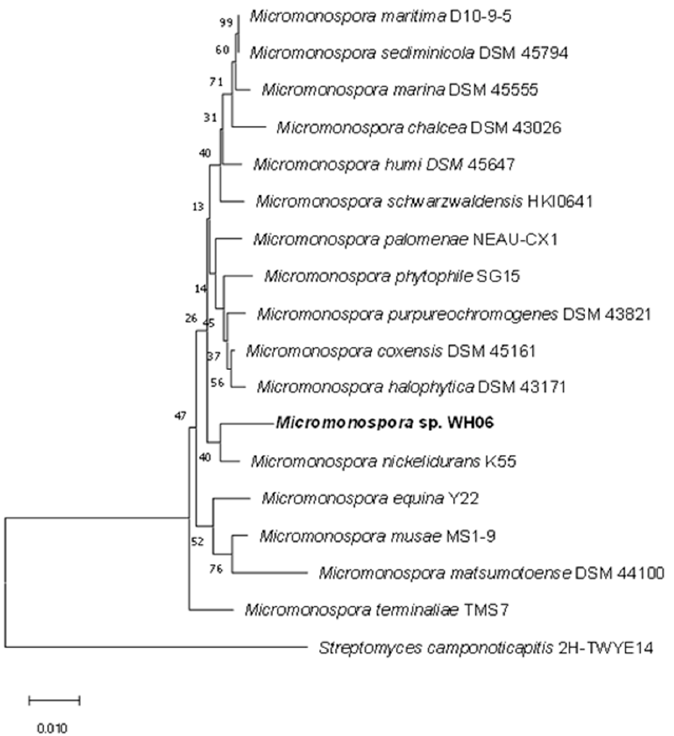
Figure 2. The neighbor-joining phylogenetic tree of Micromonospora sp. WH06 on the basis of 1000 replicates.